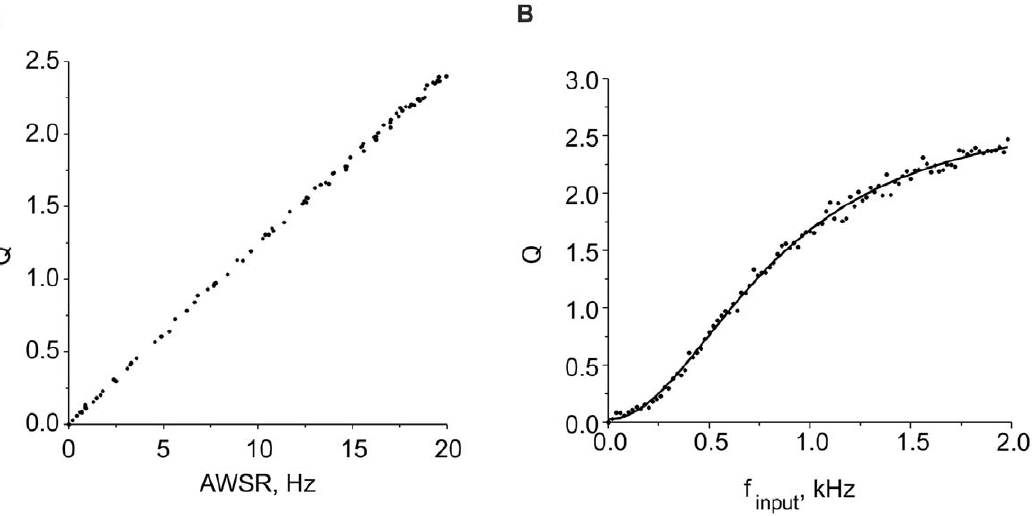
Figure 2. Characteristics of average activity. A. Average activity values versus average spiking rate (AWSR) calculated in the model Eqs. (1)–(6) for different input frequencies over the time window T=2 min . B. Average activity Q versus input frequency. The solid curve shows the logistic curve (Eq. (8)) fitting the data. Parameter values: I th =4.5 m A/cm 2 , b=6, k q =0.01, a q =0.0001 mses 2 1 , and b q =0.01 msec 2 1 .